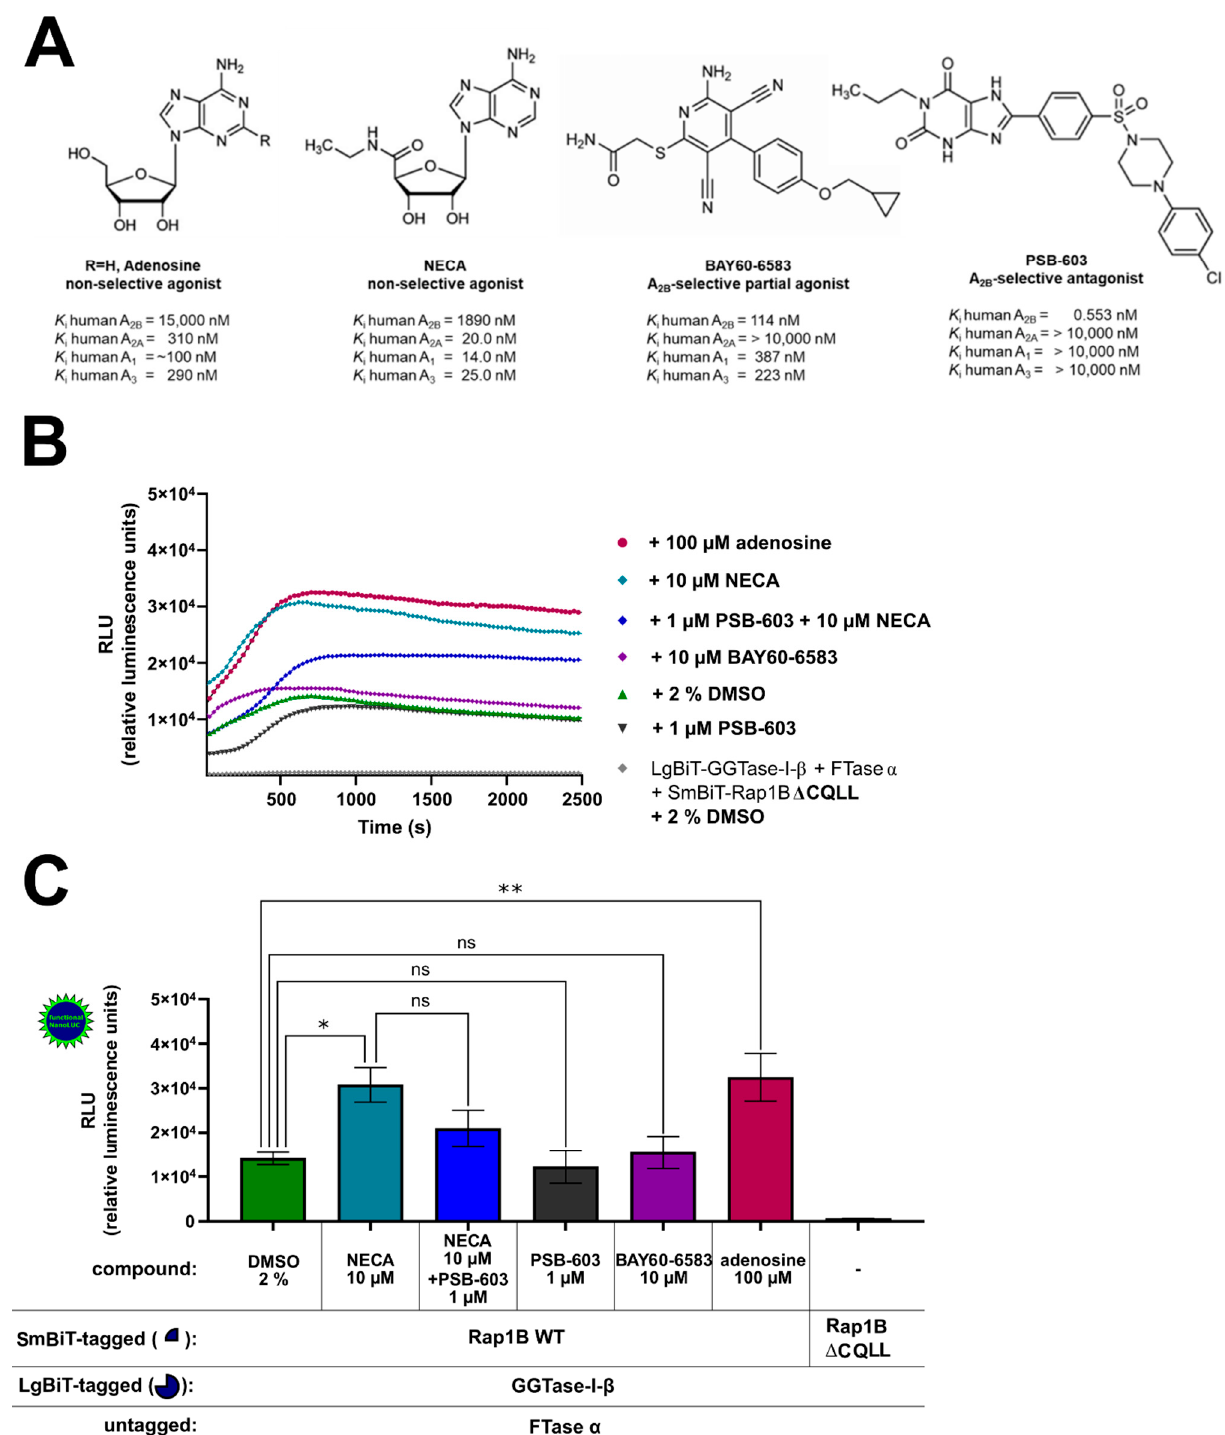
Figure 4. Effect of A 2B AR agonists and antagonists on the interaction of GGTase-I and Rap1B WT. HEK293 cells stably expressing the A 2B AR were transiently transfected as described above. ( A ) Selected non-selective AR agonists (adenosine, 5´- N -ethylcarboxamidoadenosine (NECA)), A 2B AR-selective partial agonist [2-({6-amino-3,5-dicyano-4-[4-(cyclopropylmethoxy)phenyl]pyridin-2-yl}sulfanyl)acetamide] (BAY60-6583), A 2B AR-selective antagonist (8-(4-[4-(4-chlorophenyl)piperazine-1-sulfonyl]phenyl)-1-propylxanthine (PSB-603)), and their affinities for the different adenosine receptor subtypes [61,62]. ( B ) Twenty-four hours after transfection, the cells were pre-treated for 30 min with the selective A 2B AR antagonist PSB-603 1 µM or 1% DMSO at 37 °C in OptiMEM me- dium. Then the cells were stimulated for 15 min with the non-selective adenosine receptor agonist NECA (10 µM), the